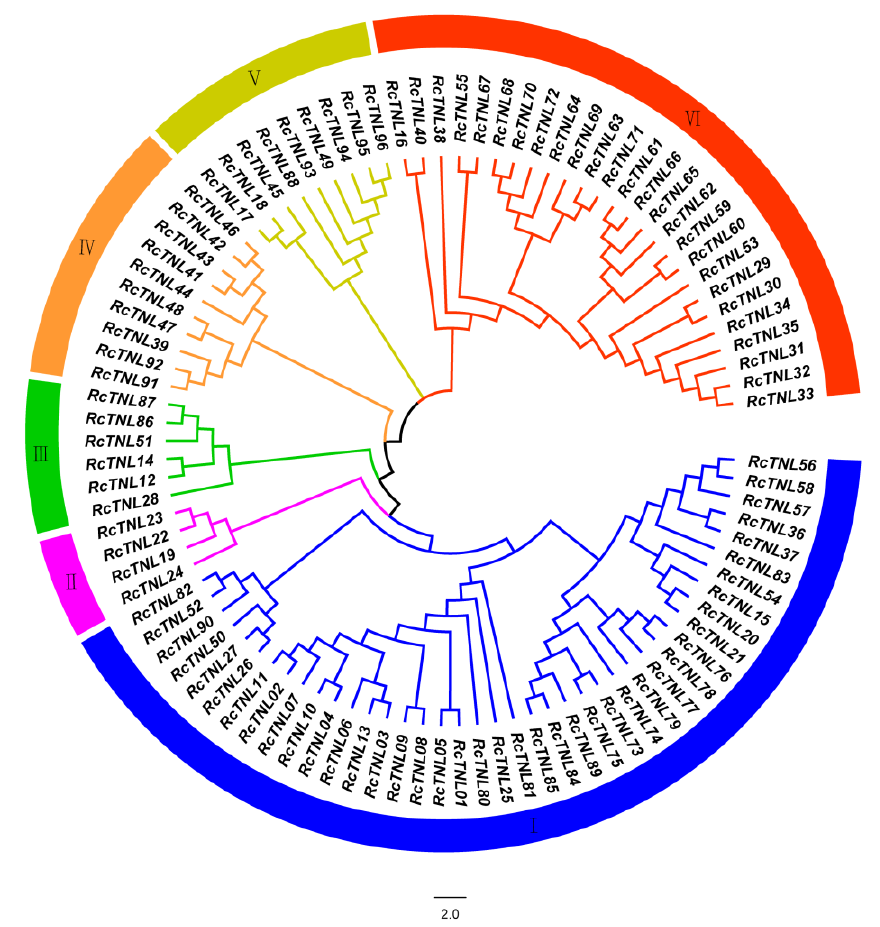
Figure 2. Phylogenetic analysis of TNL proteins in R. chinensis . The innermost circle is a phylogenetic tree of RcTNL proteins constructed by MEGA X using the maximum likelihood method; the colors represent the six clades. The outermost circle uses blocks of the same six colors to represent the clades; the Roman numerals in the blocks are the clade numbers.